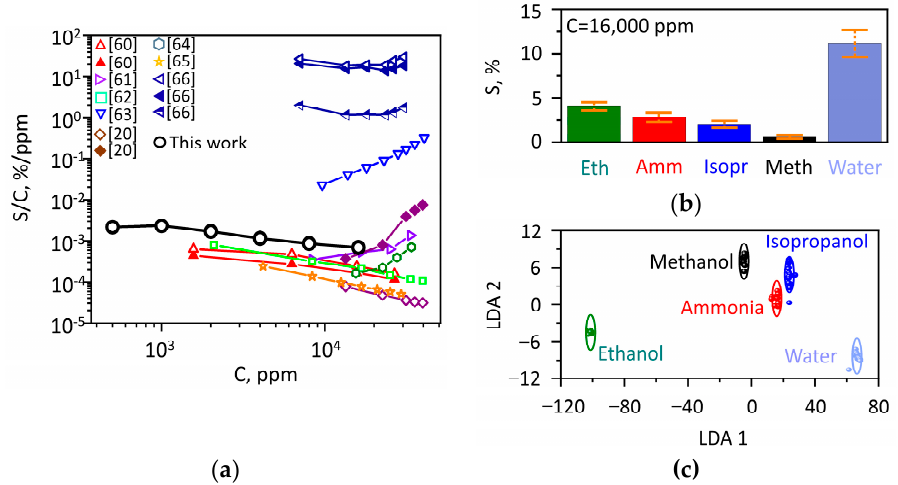
Figure 8. The gas selectivity of Ti 0.2 V 1.8 c MXene-based sensors to volatile analyte molecules under study: ( a ) [20,60–66] the comparison of chemiresistive response to H 2 O vapors with literature data dealing with sensors based on titanium carbide MXenes structures; ( b ) the response to the analytes present at C = 16,000 ppm; ( c ) results of LDA processing the vector signals of 5-element sensor array to the analytes; 2D cross-section of 4D LDA space is present, points are vector signals to analytes present at 16,000 ppm of concentration, ellipses are built around gravity centers of analyte-related classes with 0.9 confidence under normal distribution.